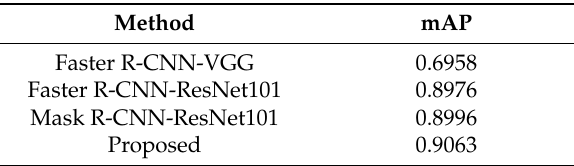
Table 1. Comparisons with Faster R-CNN and Mask R-CNN on the Fujian dataset in terms of detection